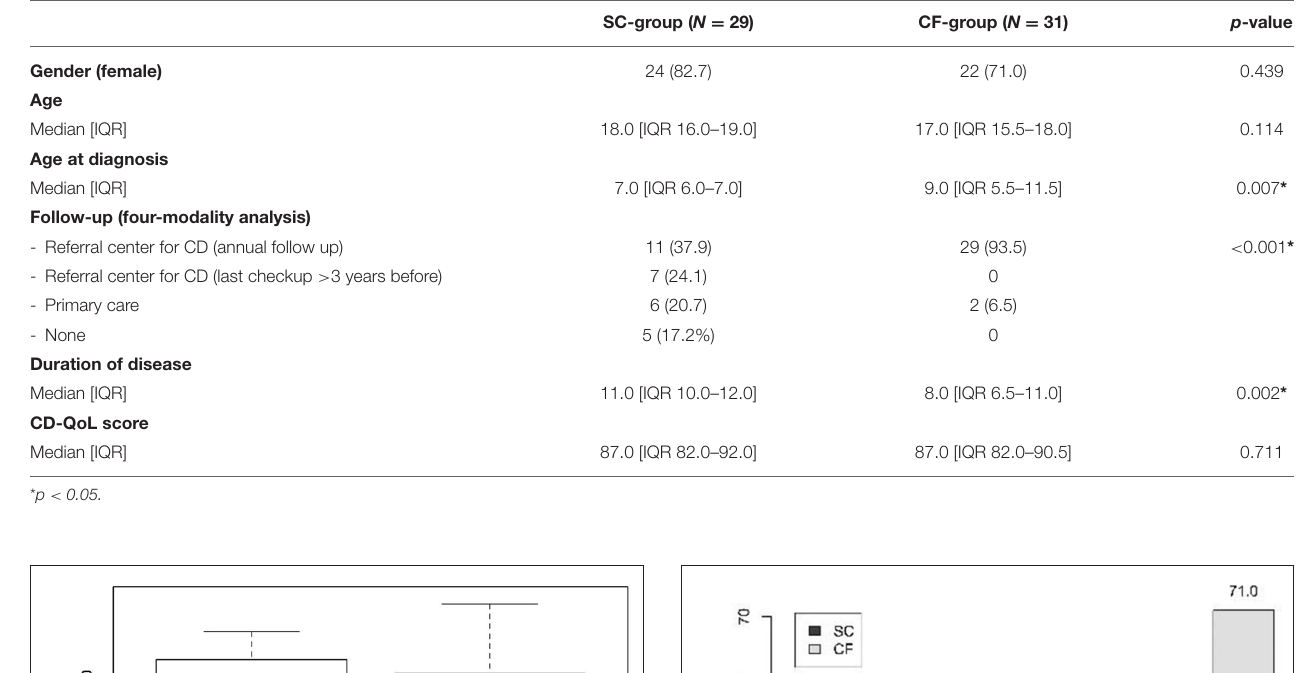
TABLE 1 | Characteristics of the screen-detected group and of the case-finding group.